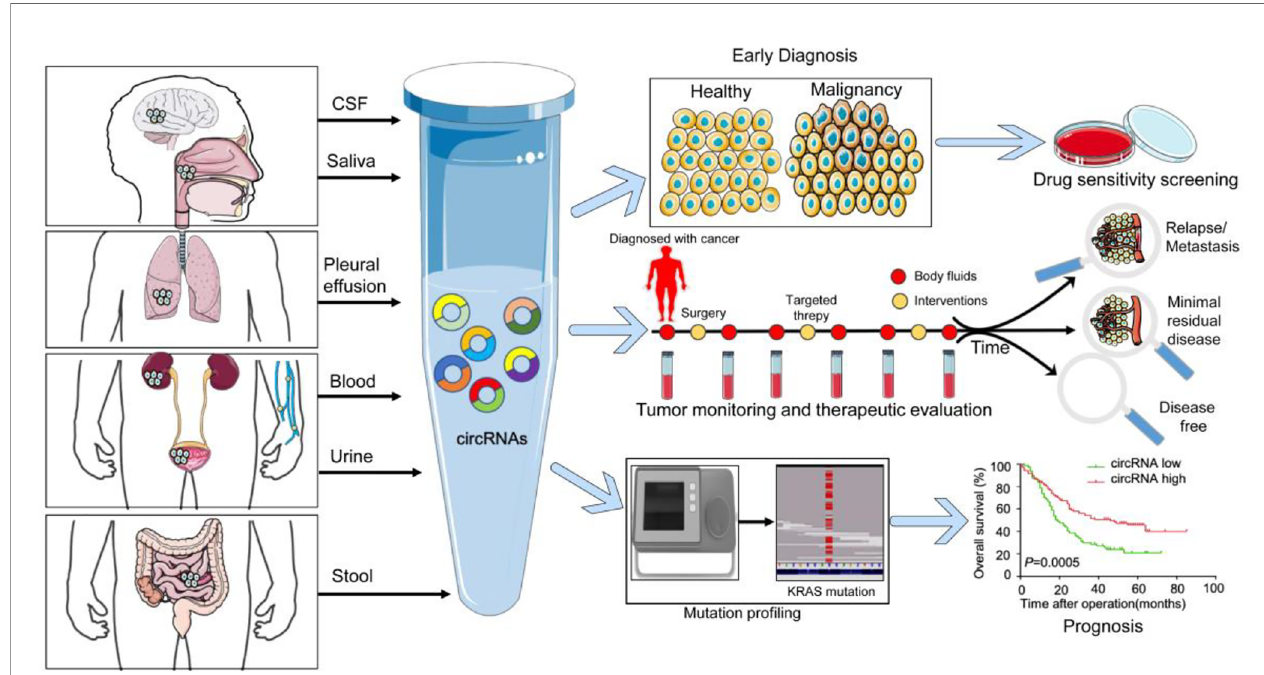
FIGURE 1 | The value of circRNA as a liquid biopsy marker in tumor diagnosis and precision medicine. Schematic representation of different body fl uids that contain circRNAs, speci fi cally including cerebrospinal fl uid (CSF), saliva, pleural effusions, blood, urine, and stool. The localization of the primary or metastatic lesions in fl uences the presence of circulating circRNAs in individual body fl uids. As indicated, cancers can be detected through analysis of the circRNA content derived from the bio fl uids and further predict the sensitivity of treatment drugs. Longitudinal monitoring of circRNAs could be used to monitor tumor progression and therapeutic effects. Genomic mutation associated with the circRNA expression could be used to assess